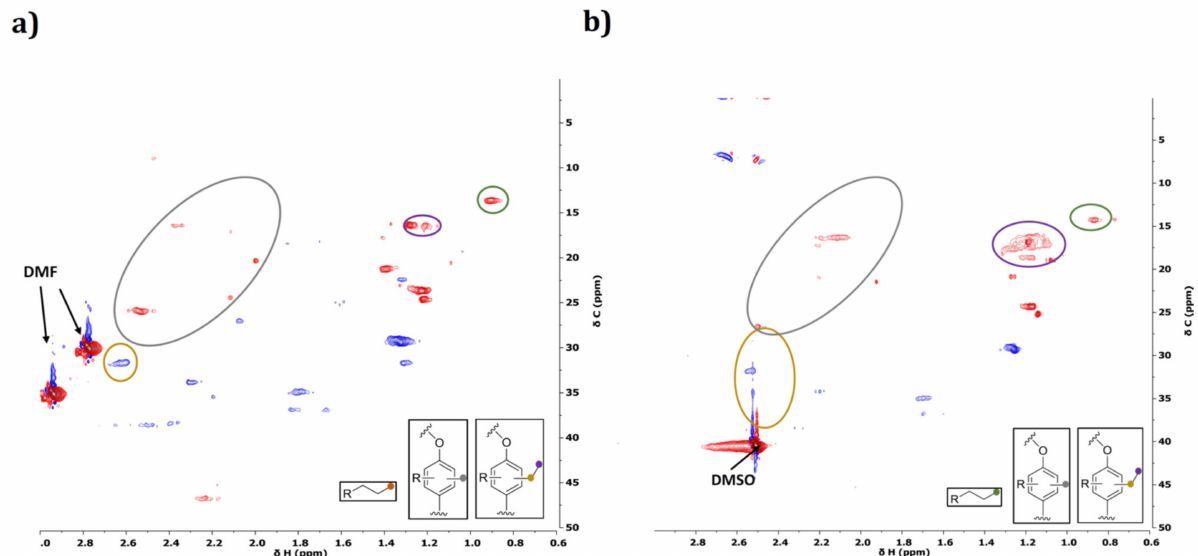
Figure 18. Side-chain region (non-oxygenated) of HSQC NMR spectra of initial ( a ) and Klason phase after reaction without catalyst in water/EtOH ( b ).